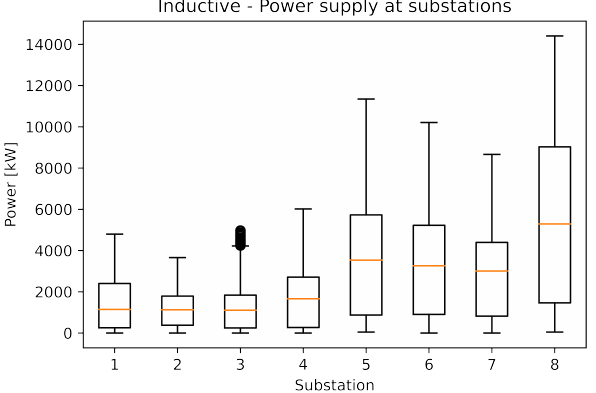
Figure 10. Inductive scenario charging